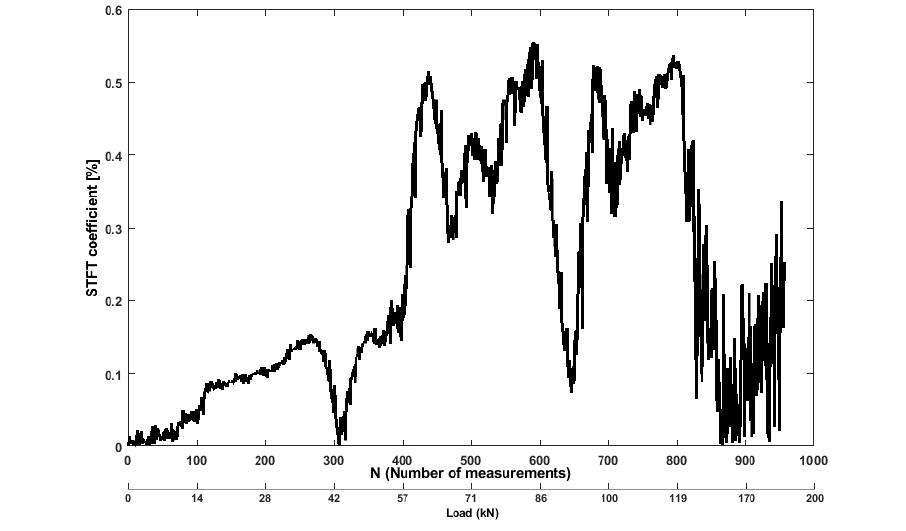
Figure 16. Values of STFT coefficient feature from ultrasonic pair S01R04 time